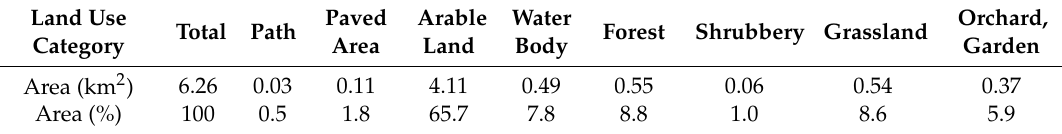
Table 1. The land use categories in the study